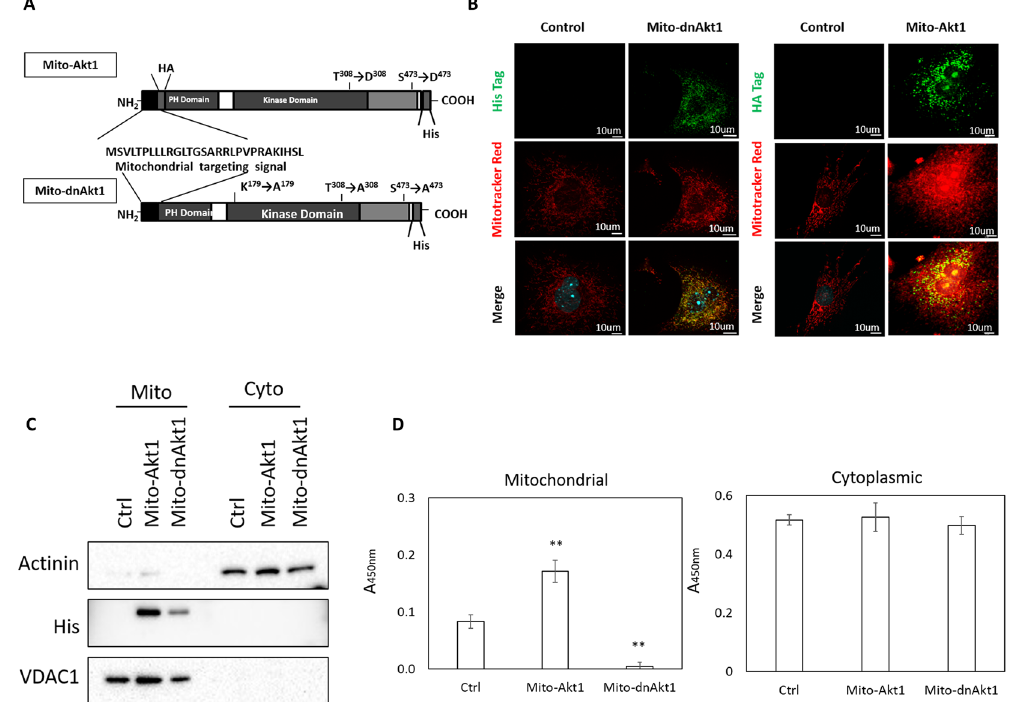
Figure 1. Mitochondria-targeting adenoviral vectors. ( A ) Constructs of adenoviral vectors expressing mitochondria-targeting constitutively active and dominant negative Akt. The constructs were tagged with either HA or His. ( B ) Mitochondria-targeting was achieved in murine fibroblasts (MEF). The cells were transduced with the control adenovirus, Mito-dnAkt1 or Mito-Akt1 and the protein products of transgene was stained with anti-His tag or anti-HA tag antibodies, and mitochondria stained with Mitotracker Red. Scale bar − 10 um. ( C ) Distribution of mutant Akt in MEF mitochondria and cytoplasmic fractions. MEFs were transduced with adenoviral vectors and harvested 48 hours post transduction. Mitochondria and cytoplasmic fractions were subfractionated as described in the method section. Both Mito-Akt1 and Mito-dnAkt1 were His-tag labelled. Actinin was used as cytoplasmic marker, while VDAC1 was used as mitochondrial marker. The mutant Akts specifically localized to mitochondria. ( D ) Akt activity assays. Protein lysates from mitochondria (20 ug) and cytoplasmic fractions (60 ug) were used to determine Akt kinase activity assay as described in the Methods section. Bar graph represents the results summarized from 3 independent experiments in duplicates. ** p ≤